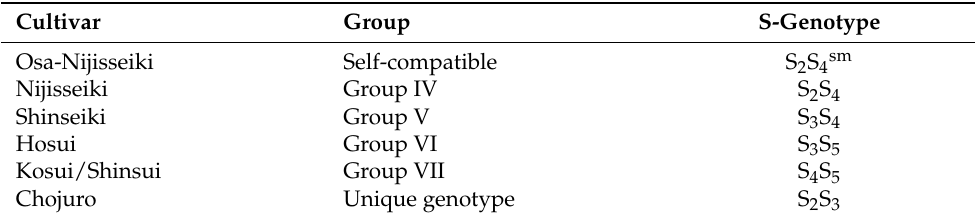
Figure 2. Self-incompatibility reactions: ( a ) cross-compatible, ( b ) semi-compatible and ( c ) cross- incompatible (Source: created in Biorender.com). Table 3. Incompatibility groups and S-genotypes of nashi cultivars grown in Australia (adapted from Hal á sz and Heged˝us [36]).